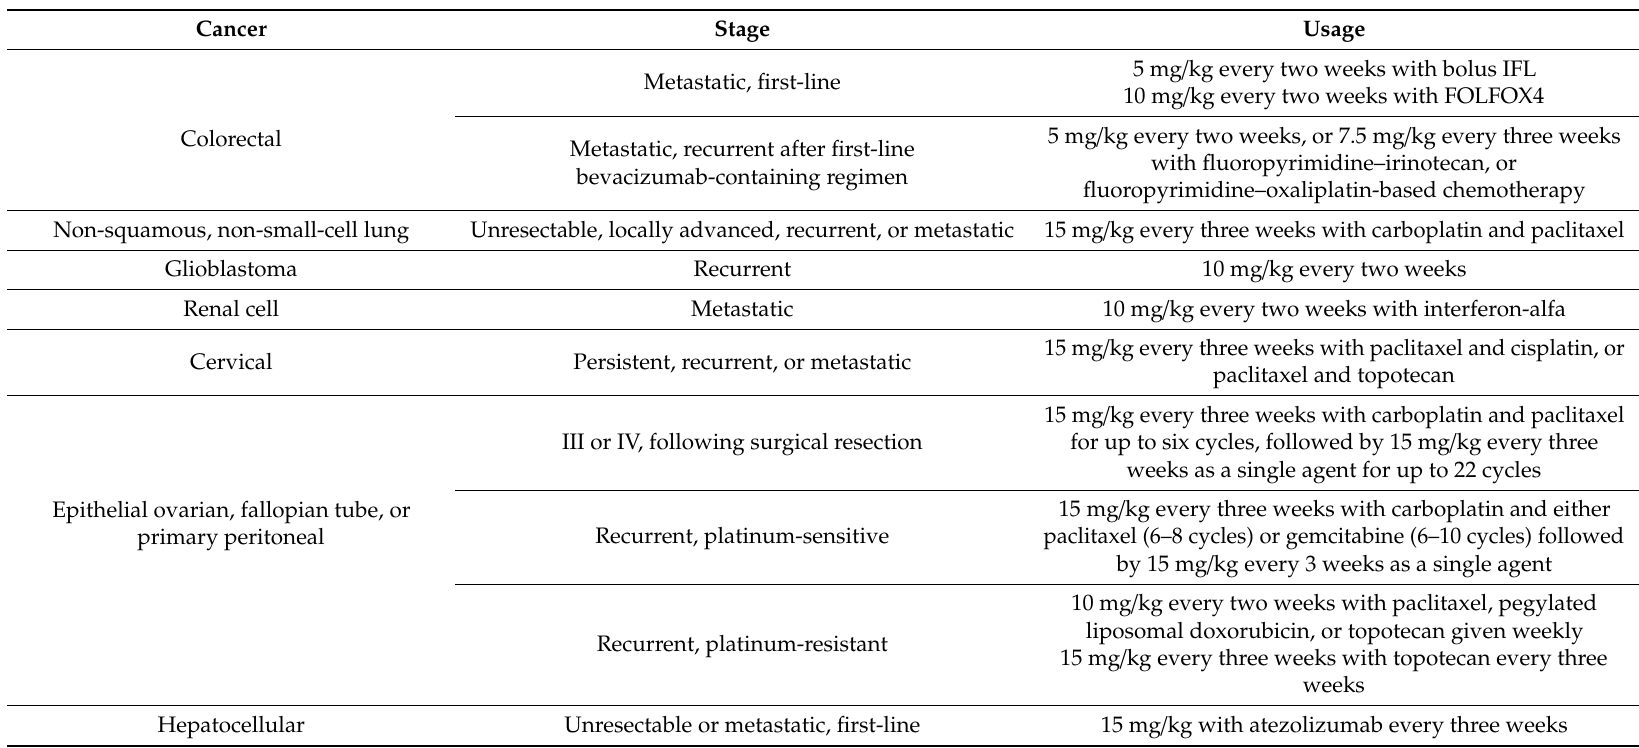
Table 1. Food and Drug Administration approved indications for bevacizumab